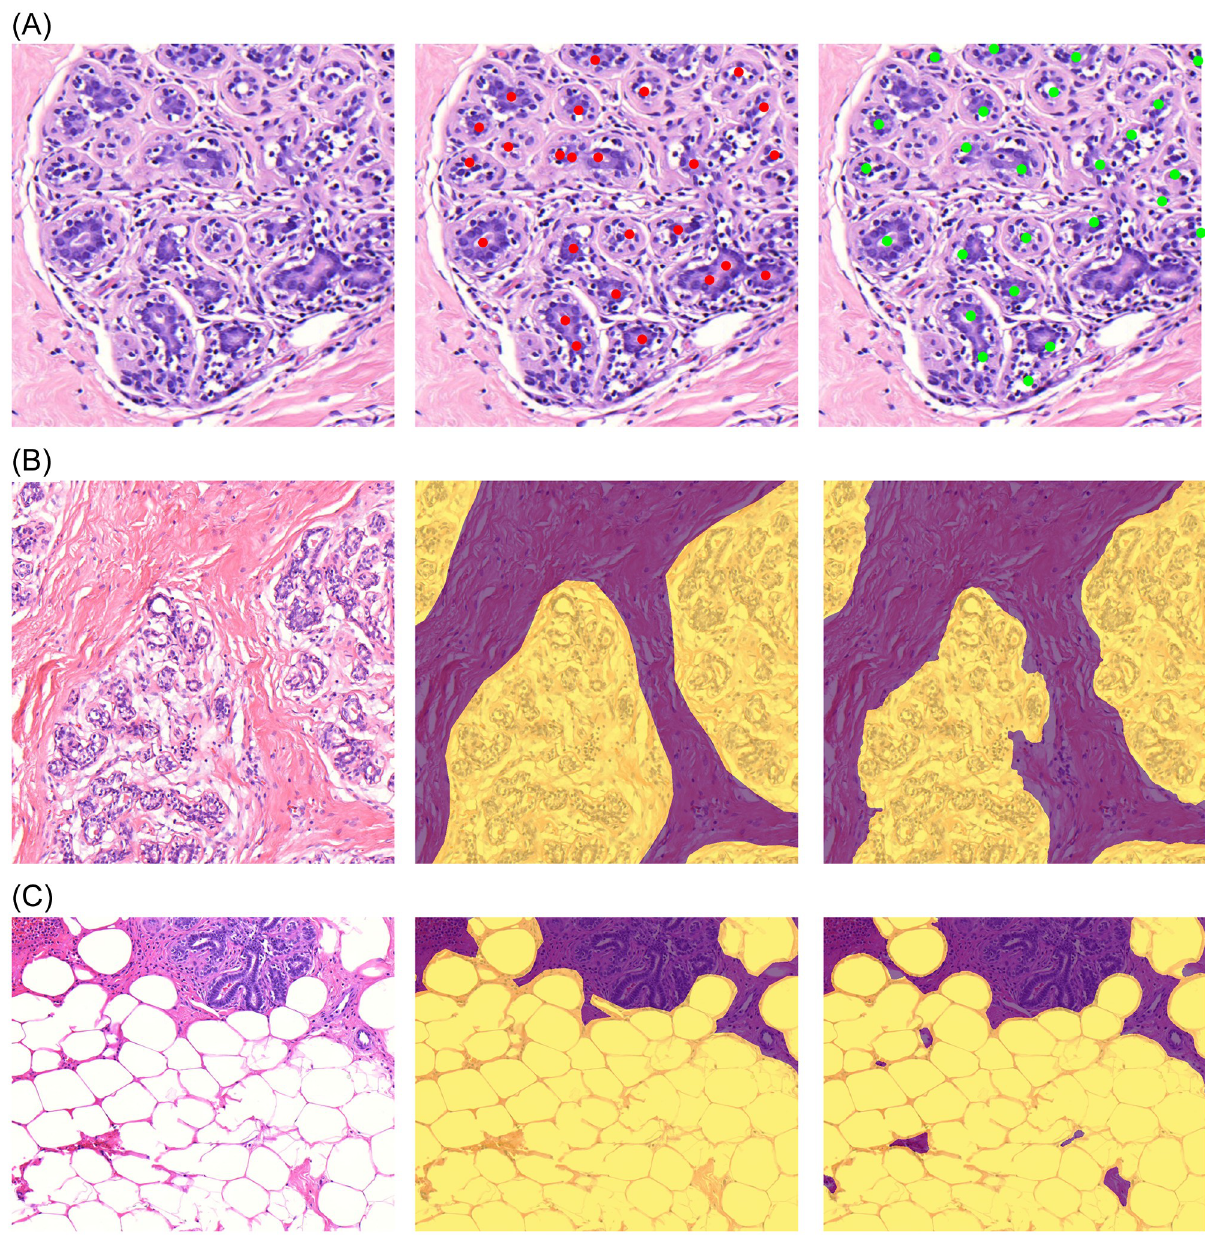
Fig 2. Results of the acini detection (A), terminal duct lobular unit (B), and adipose tissue (C) segmentation algorithms. The original images are in the left column, the middle column shows ground truth as annotated by human observers, and the detections and segmentations performed by the automated method are displayed in the right